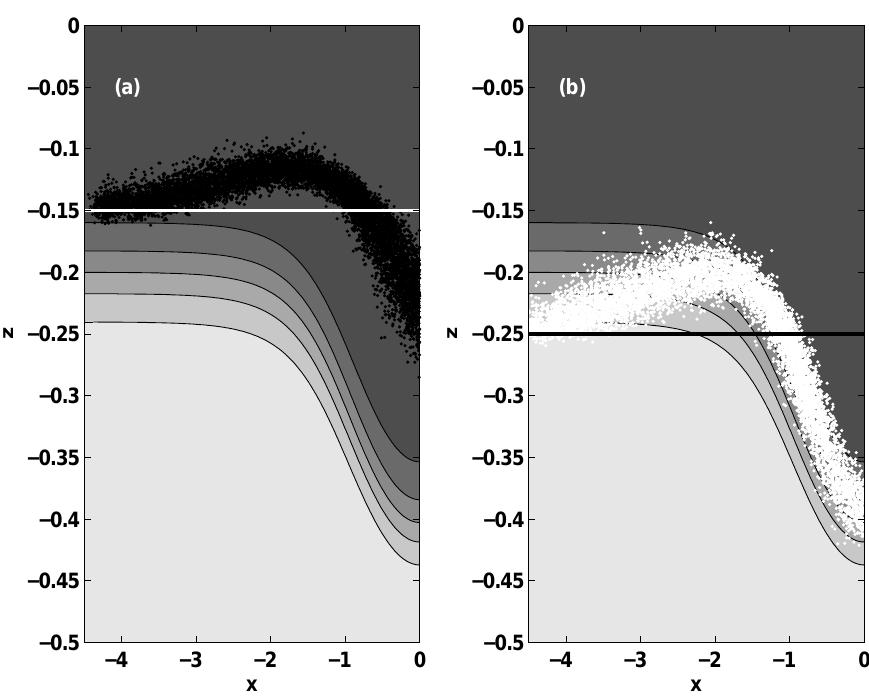
Fig. 9. The effect of equilibrium light level on the steady state distribution of particles near the rear of the wave for return to equilibrium photic level swimming. (a) z l =− 0 . 15, (b) z l =− 0 . 25. Equilibrium level denoted by a solid line. Five isopycnals are